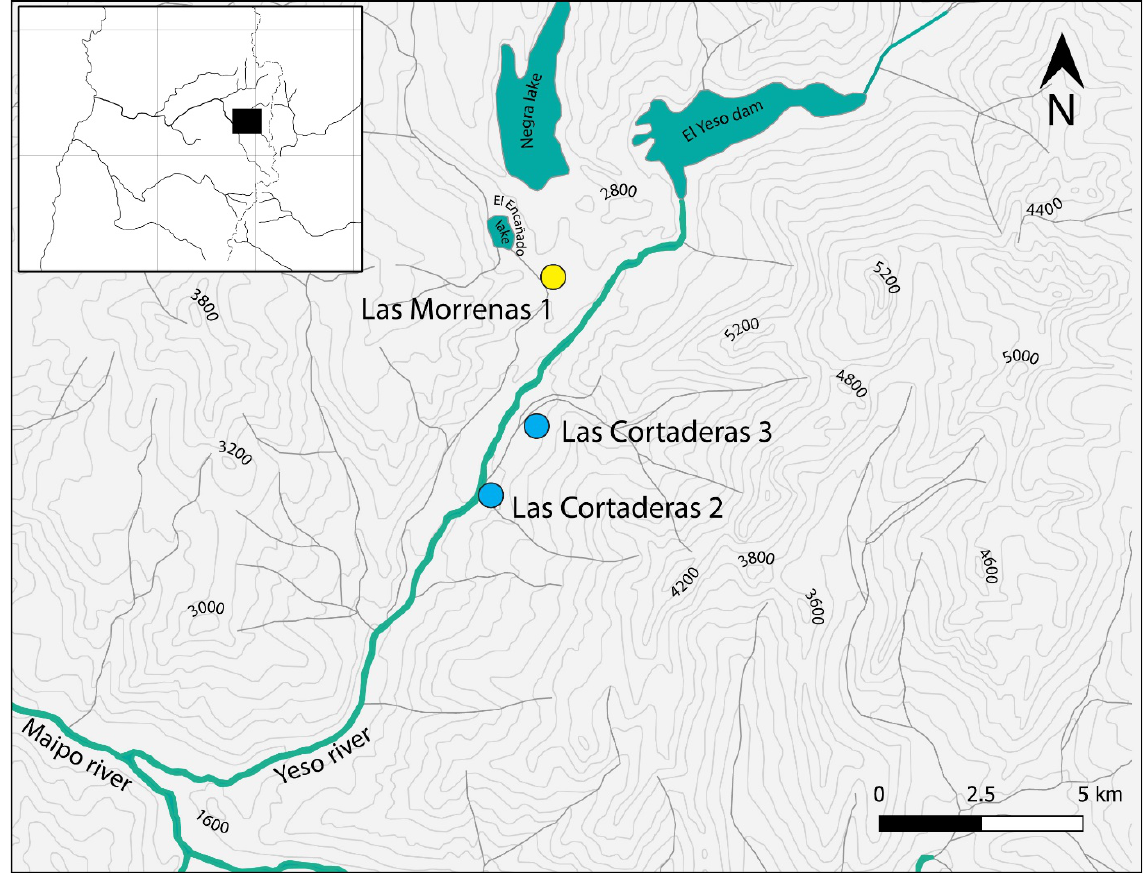
Figure 5. Yeso River